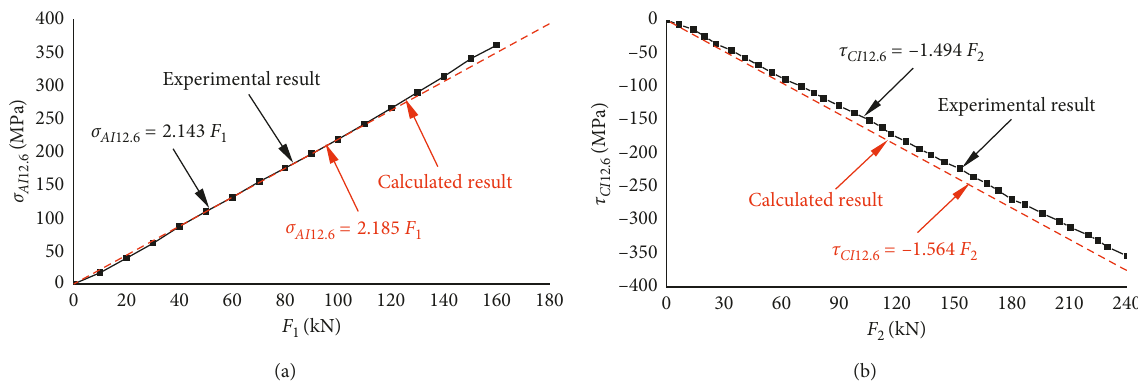
AI 12 . 6 ; (b) calculated results and experimental results of